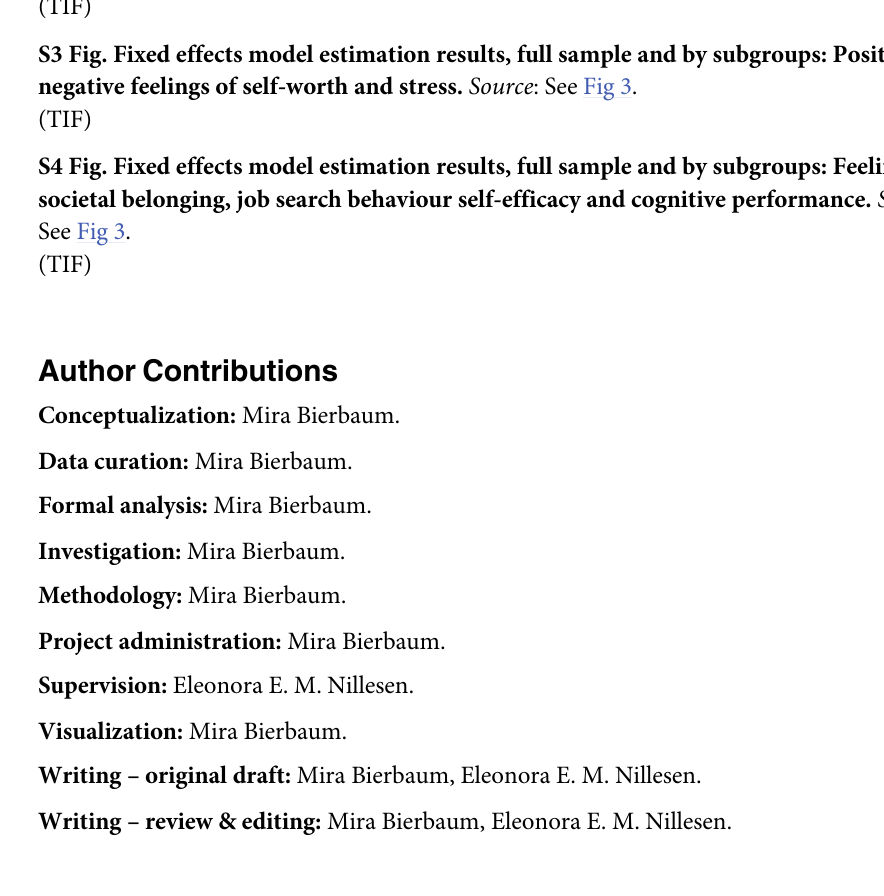
S3 Fig. Fixed effects model estimation results, full sample and by subgroups: Positive and negative feelings of self-worth and stress. Source : See Fig 3. S4 Fig. Fixed effects model estimation results, full sample and by subgroups: Feelings of societal belonging, job search behaviour self-efficacy and cognitive performance. Source : See Fig